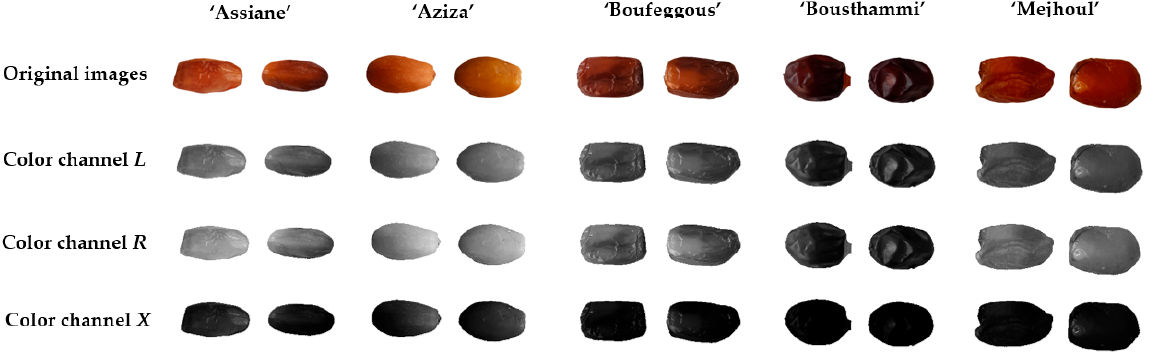
Figure 1. Exemplary original images of date palm fruits belonging to different varieties and images in selected color